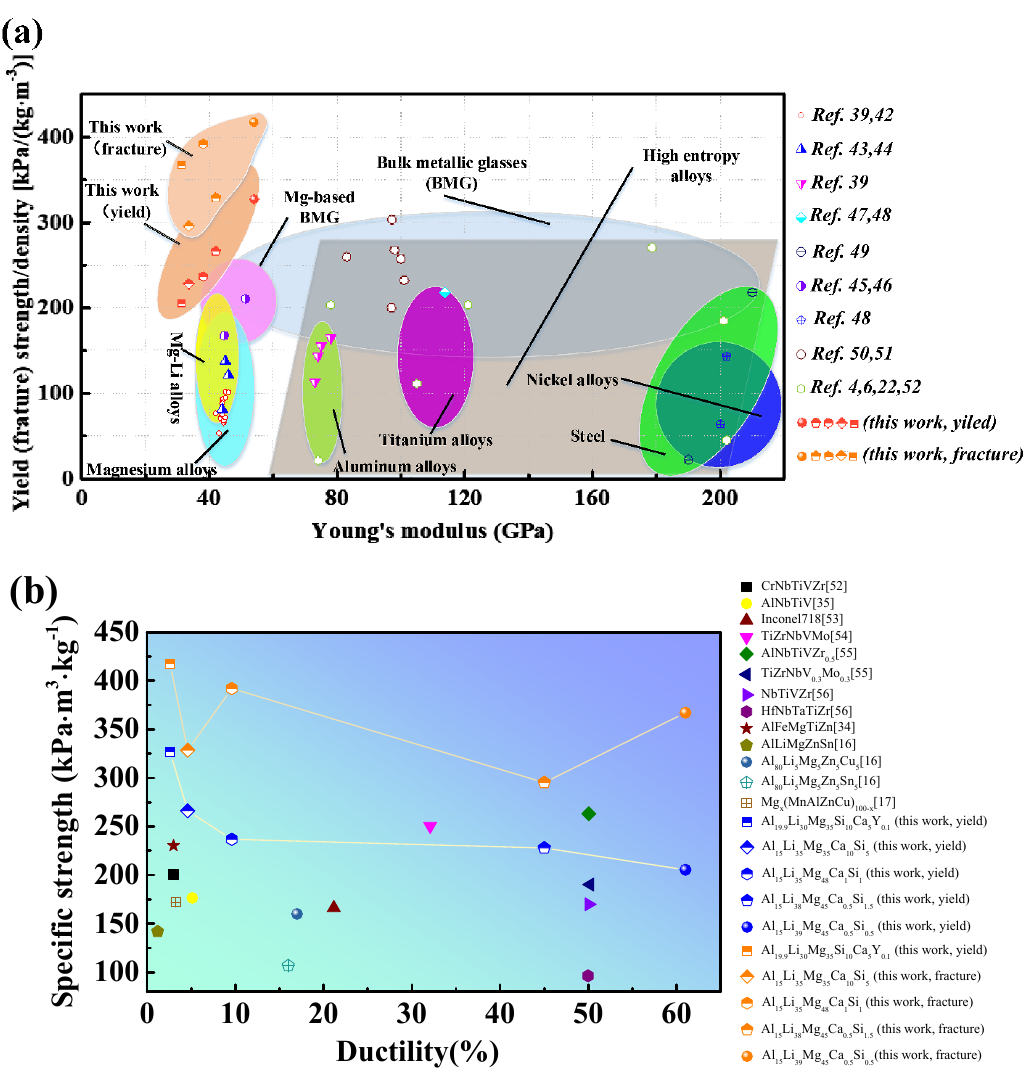
Figure 8. Comparison between five ULW-CCAs and other reported alloys. ( a ) Specific strength as a function of Young’s modulus of five ULW-CCAs and conventional alloys. ( b ) Specific strength vs. ductility of different CCAs.